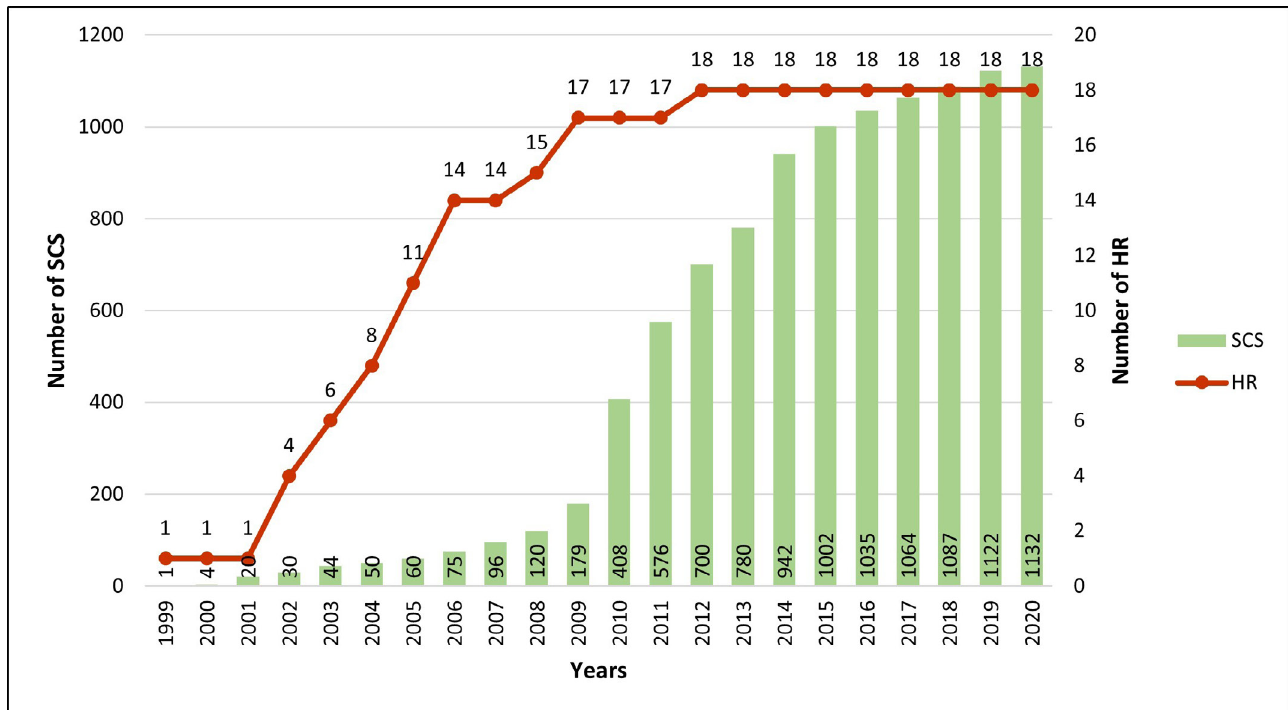
Figure 3. Timeline of SCS and Health Region coverage per year. Abbreviations: SCS: Sample Collecting Site; HR: Health Region.